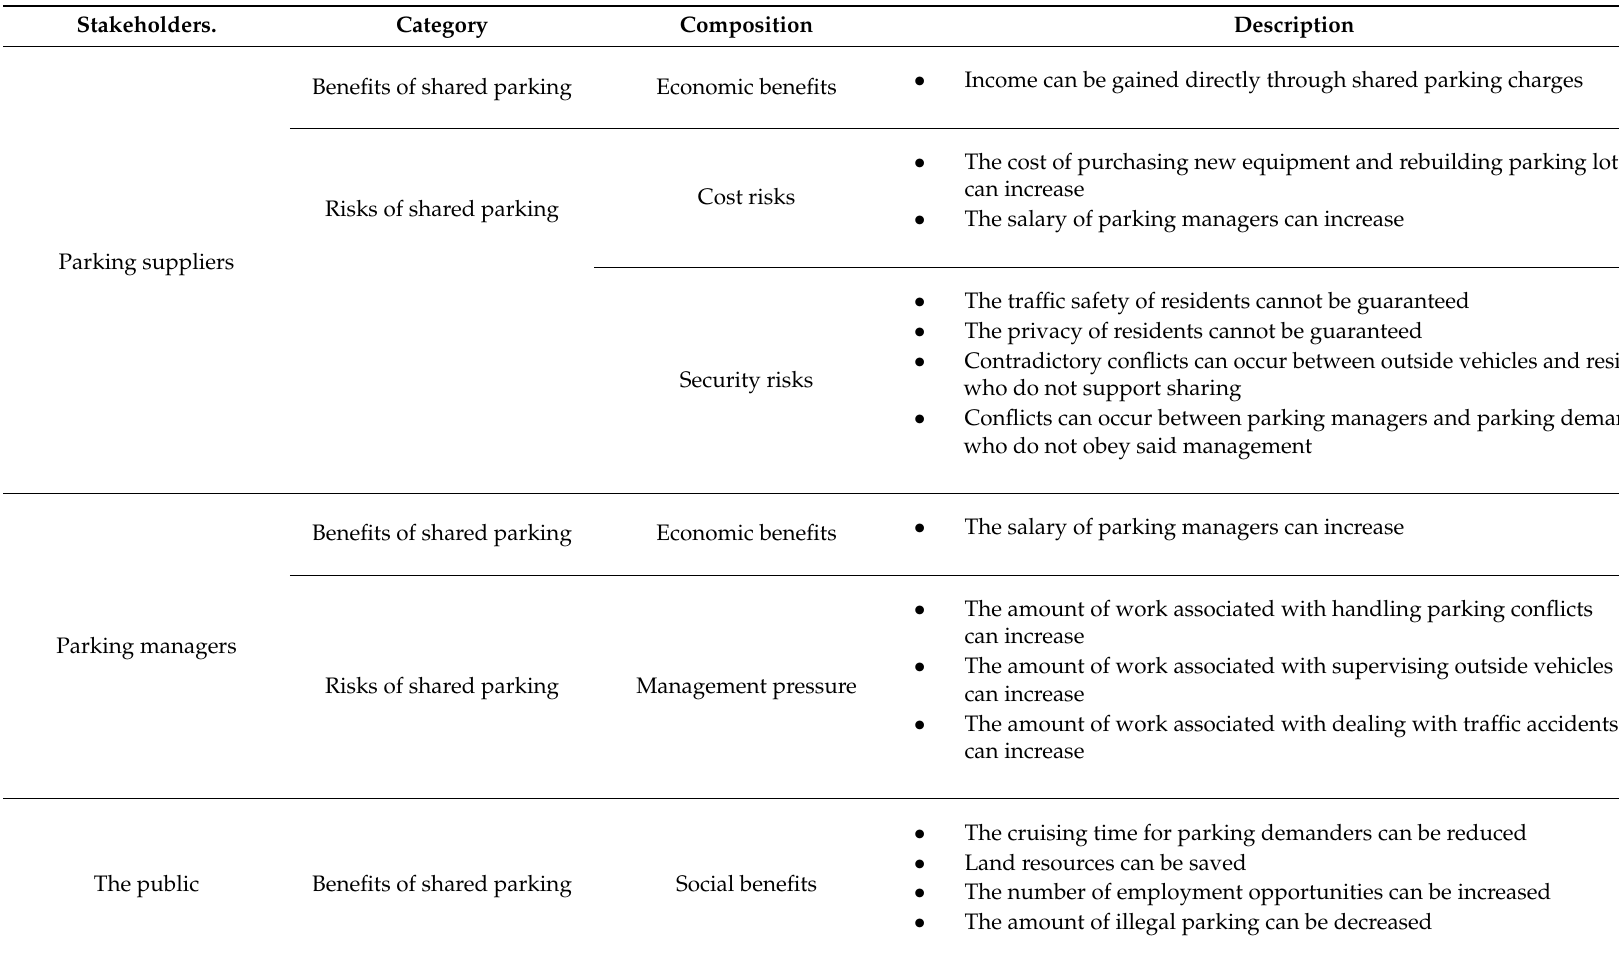
Table 1. Category and composition of the evaluation